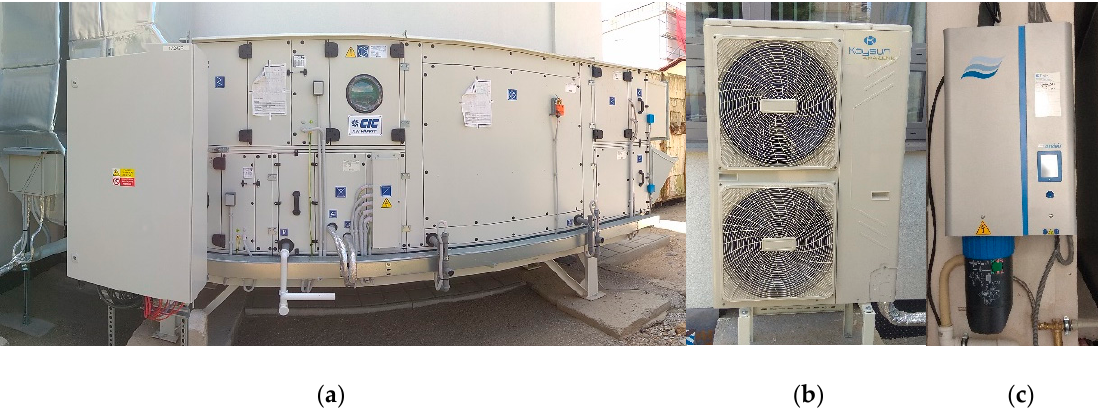
Figure 4. Location of HVAC equipment: ( a ) ventilation unit, ( b ) heat pump, and ( c ) air humidi fi er.